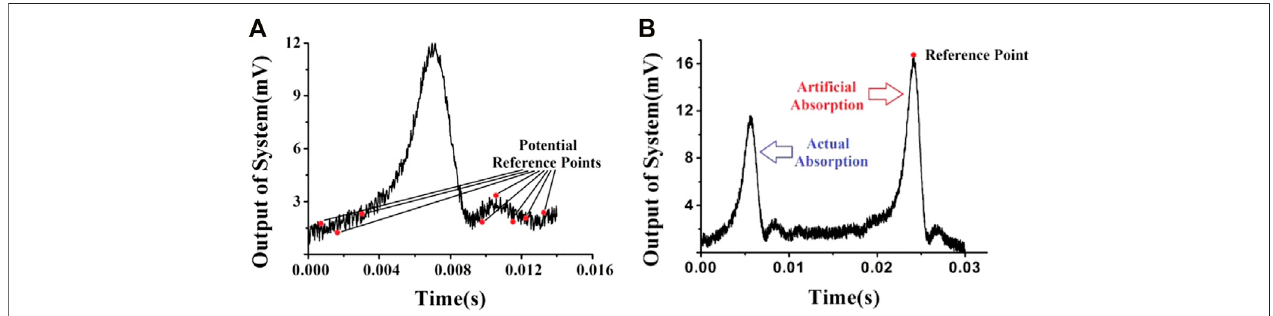
FIGURE 6 | (A) Detected signal of a single absorption line with the DA method, revealing that noise increases the dif fi culty and uncertainty of the selection of the reference point. (B) Differential detection of the signals of two absorption peaks, one of which is arti fi cial. By creating an arti fi cial absorption peak next to the real absorption zone, the reference point becomes easier to distinguish.